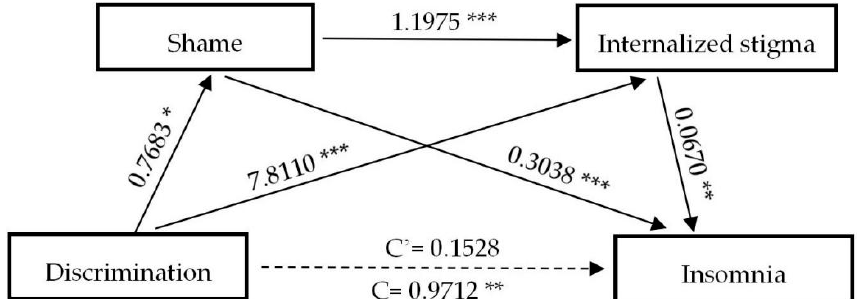
Figure 4. A serial mediation analysis of shame and internalized stigma on discrimination to insomnia. * p < 0.05, ** p < 0.01, *** p < 0.001.